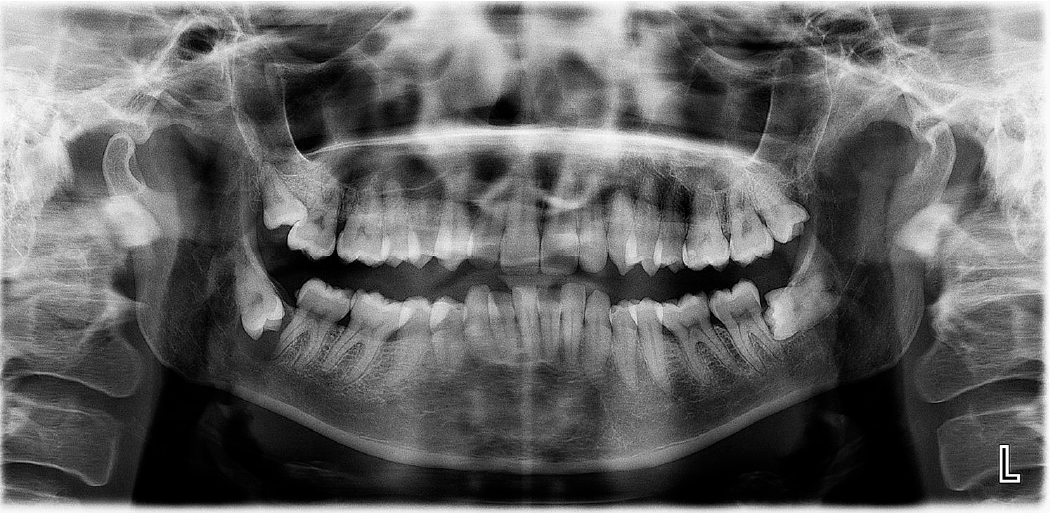
Figure 5. Panoramic X-ray of case #2.